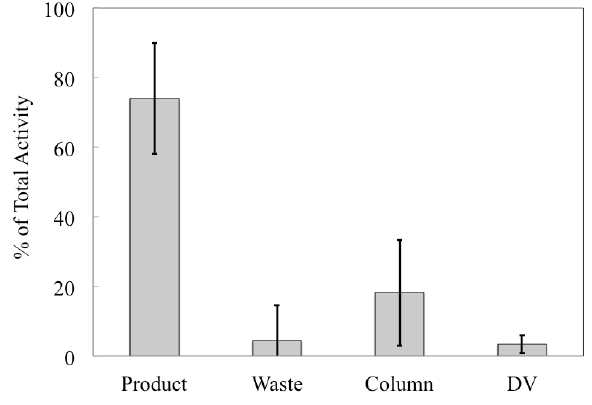
Figure 5. Distribution of 89 Zr in various components after each production. For each production, the activity in each of the four primary system components was decay-corrected to a common time point (end-of-bombardment in the cyclotron) and calculated as a percentage of the total activity. Displayed here are the average percentages for each component ± 1 σ . N = 14.